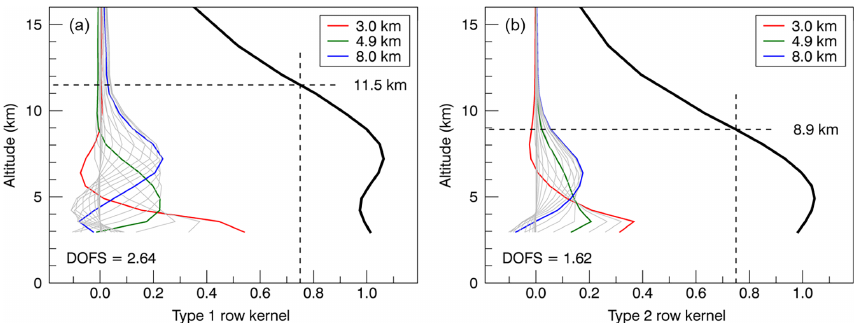
Figure 1. Averaging kernel rows of a typical H 2 O measurement at Zugspitze (29 October 2009, 13:21UTC) for two retrieval products: (a) optimally estimated humidity state (type 1) and (b) consistent {H 2 O, δ D} state (type 2). Thick black lines show the vertical column sensitivity (sum of row elements of the averaging kernel matrix).